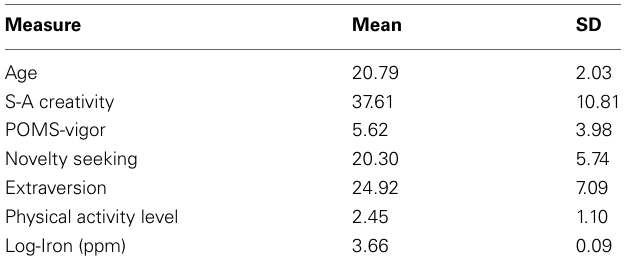
Table 1 | Psychological variables and n logarithms of iron among the study